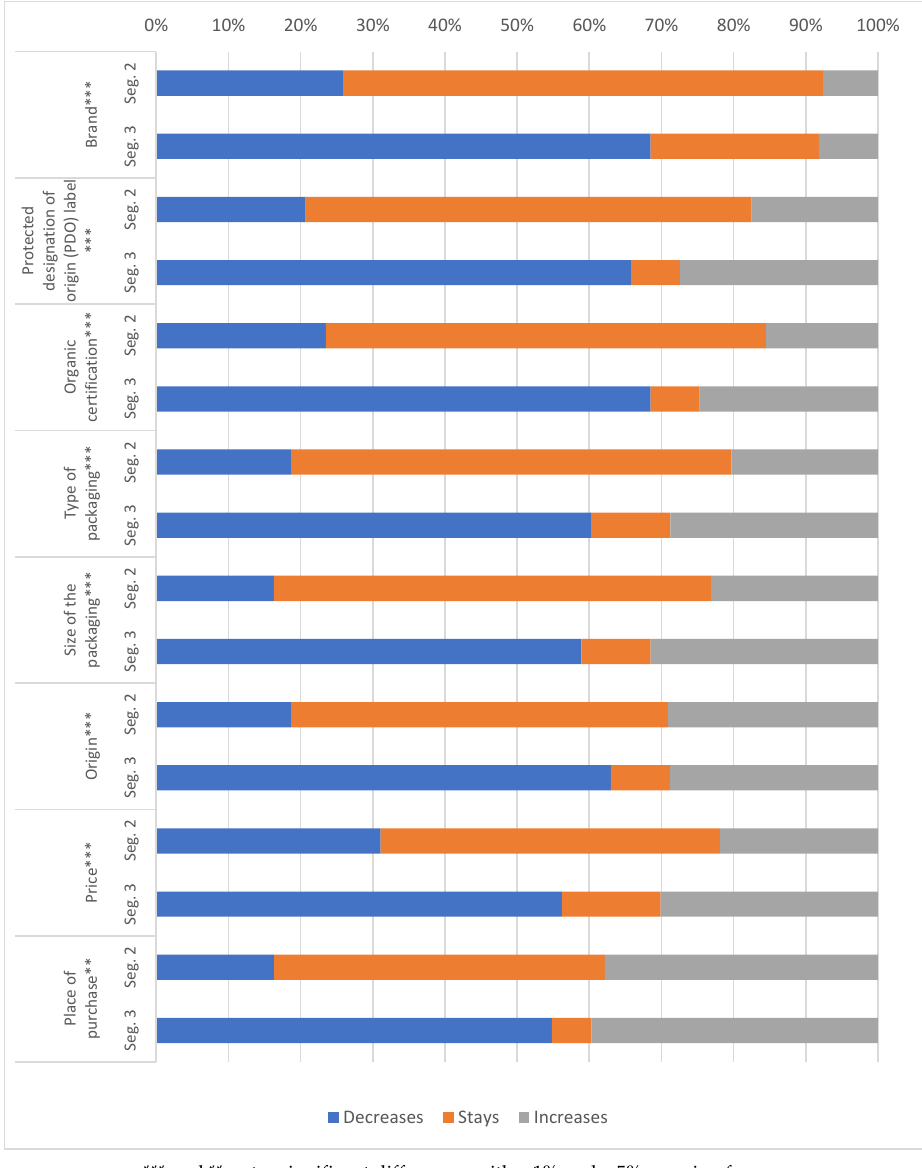
Figure 3. Change in the value assigned to the attributes.